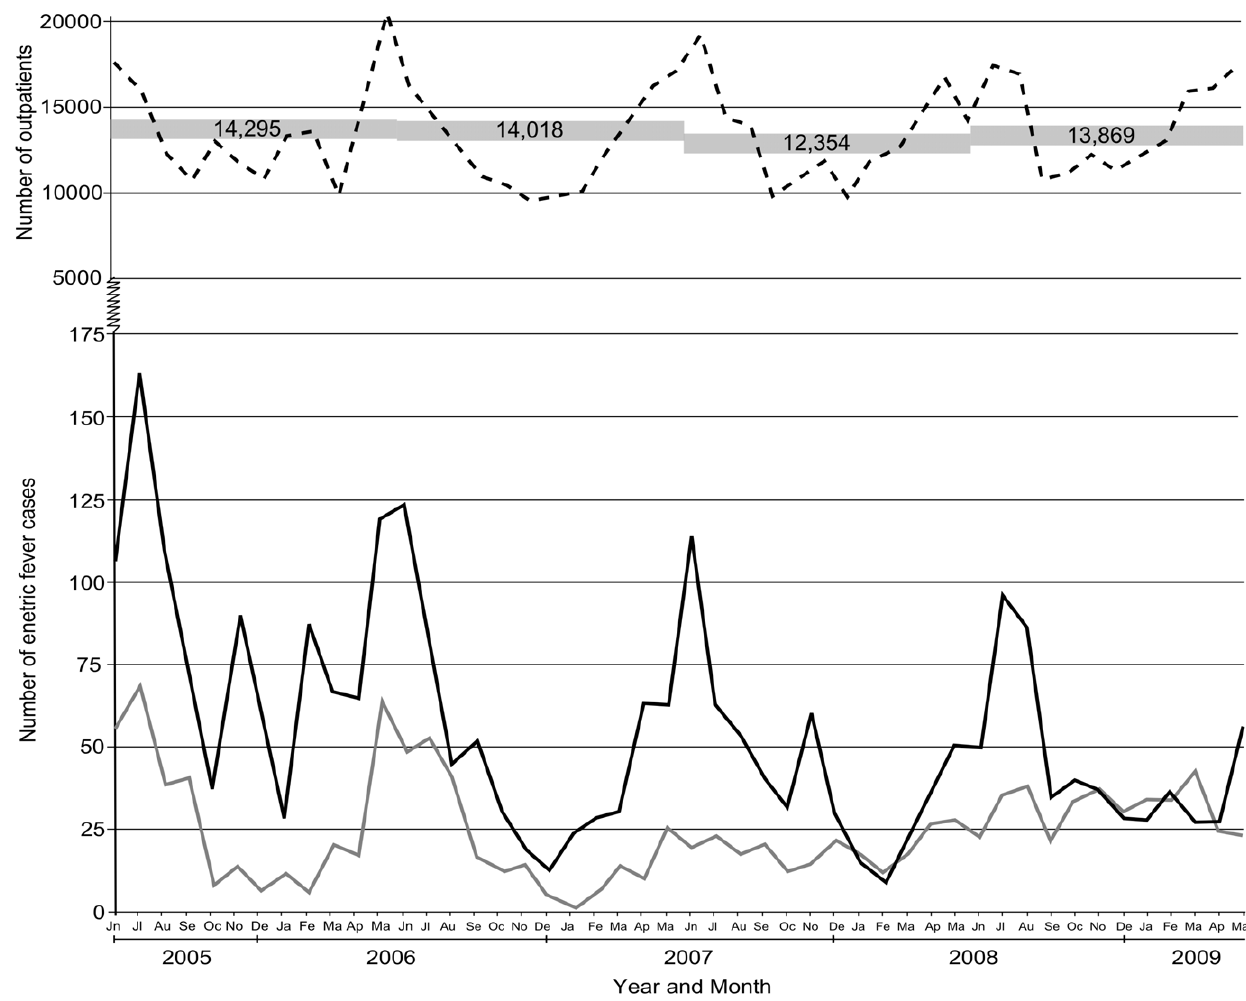
Figure 1. Enteric fever case burden in patients attending Patan Hospital, 2005–2009. Plot showing the number of culture positive enteric fever cases at Patan Hospital per month between June 2005 and May 2009 (solid black line; S . Typhi and solid grey line; S . Paratyphi A). The broken black line shows the number of patients attending the outpatient department per month over the same period, with numbers in grey boxes equating to the annual number of blood cultures performed.